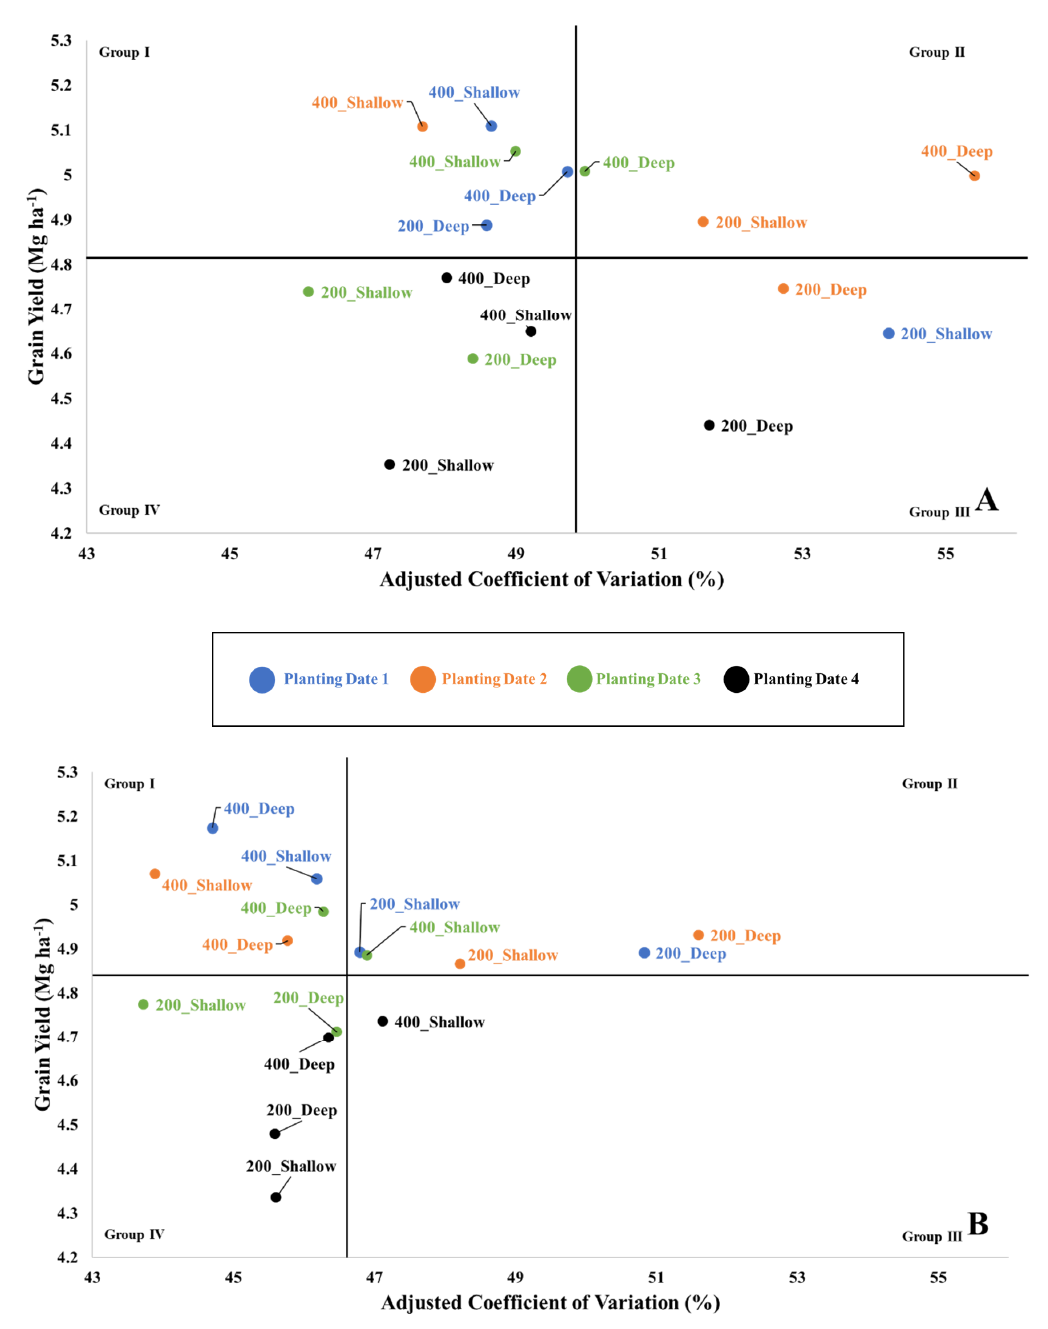
Figure 6. Biplots summarizing grain yield means vs. adjusted coefficient of variation (aCV) for each wheat line; “LQ1299A” ( A ), and “LQ1315A” ( B ). Abbreviations are as follows: (I) The first number represents the seeding rate (400—400 seeds m −2 , 200—200 seeds m −2 ). (II) The second word represents the sowing depth (Shallow—2.5 cm, Deep—5 cm). (III) Colours represent the planting date as indicated in the legend above (Planting Date 1–4, 1 equaling 0–2.5 °C soil temperature). Grouping categories are divided by a vertical line representing the mean aCV and a horizontal line representing the mean grain yield: Group I: high mean, low variability; Group II: high mean, high variability; Group III: low mean, high variability; Group IV: low mean, low variability.